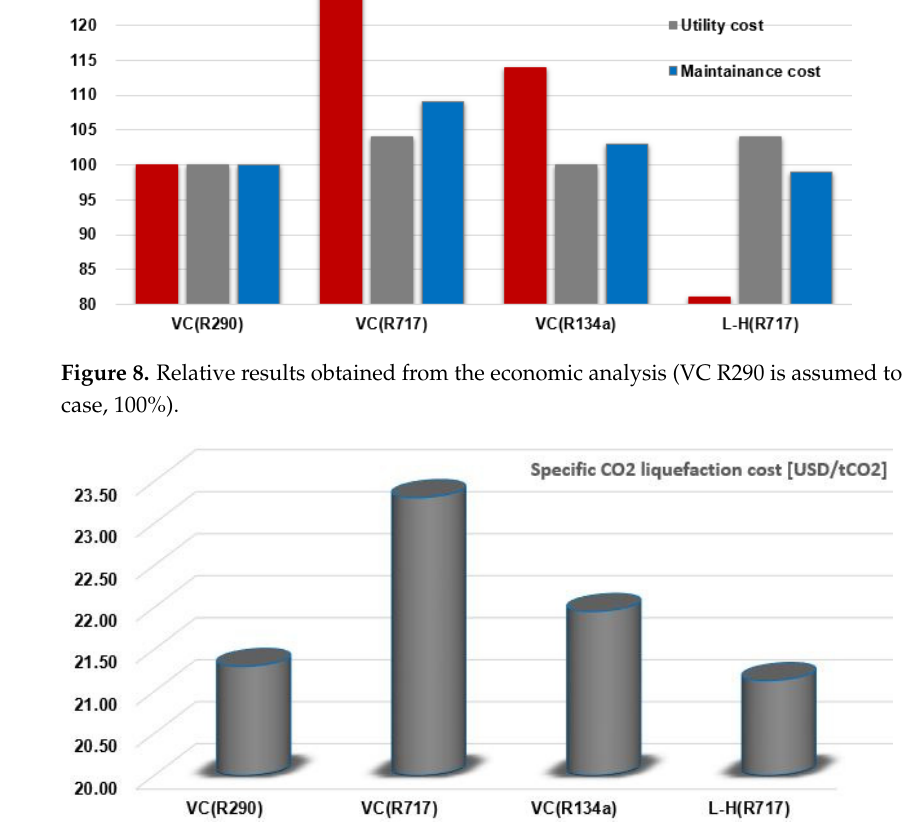
Figure 9. Specific CO 2 liquefaction cost (March 2021).